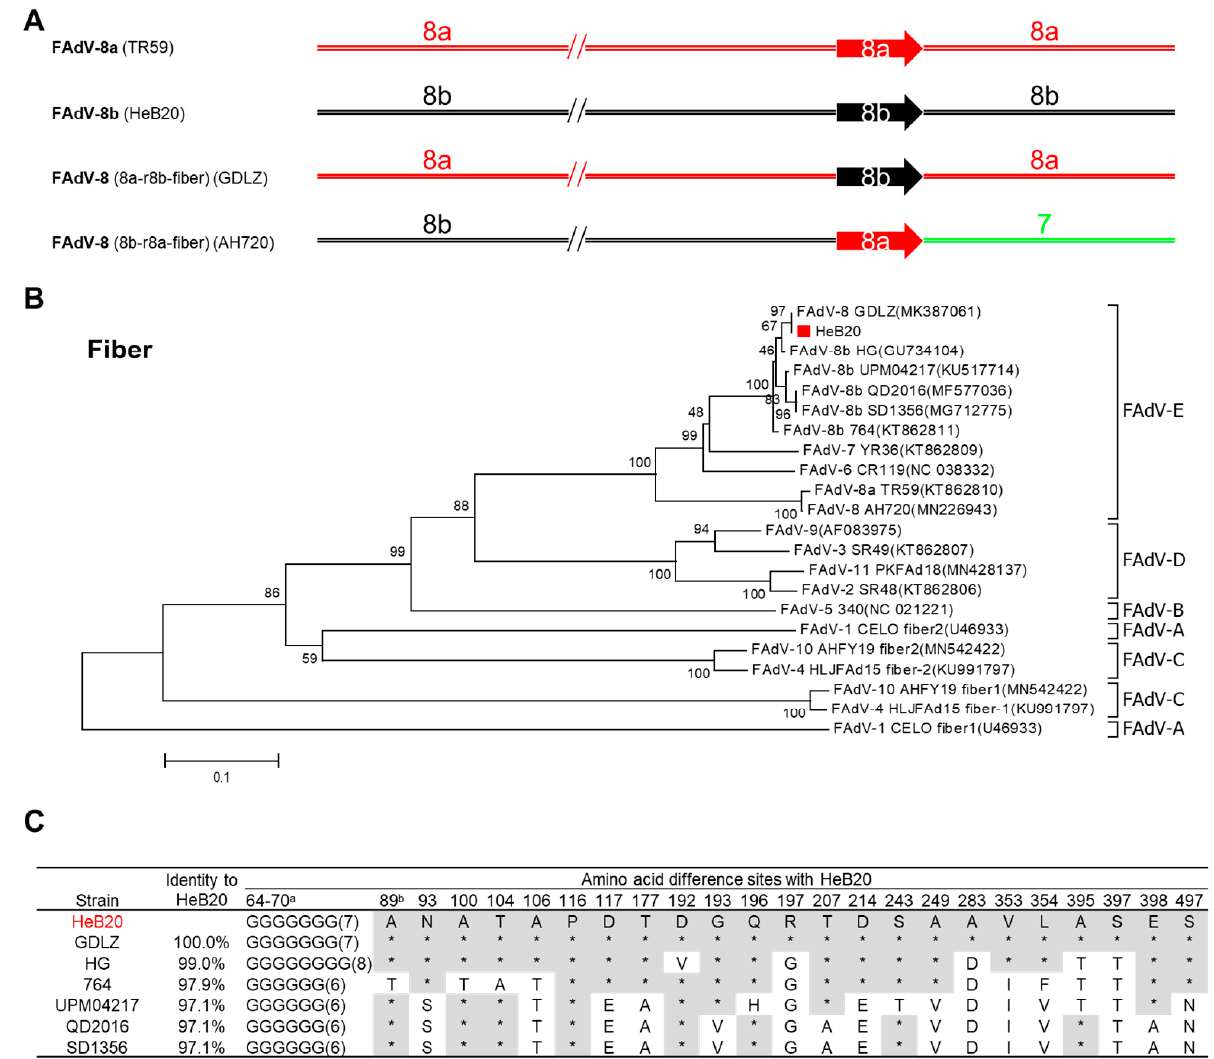
Figure 3. Recombinant and phylogenetic analysis of HeB20. ( A ) Recombinant representation of FAdV-8a (TR59), FAdV-8b (HeB20), FAdV-8 (8a-r8b-fiber; GDLZ), and FAdV-8 (8b-r8a-fiber; AH720). The arrow graphics represent fiber gene. The red, black, and green segments were from FAdV-8a, FAdV-8b, and FAdV-7, respectively. ( B ) Phylogenetic analysis of the major capsid (fiber) protein of FAdV-8b strain HeB20. Accession numbers of published fiber gene sequences are provided in the parentheses. ( C ) Sequence alignment analysis for fiber amino acid from different FAdV-8b isolates.